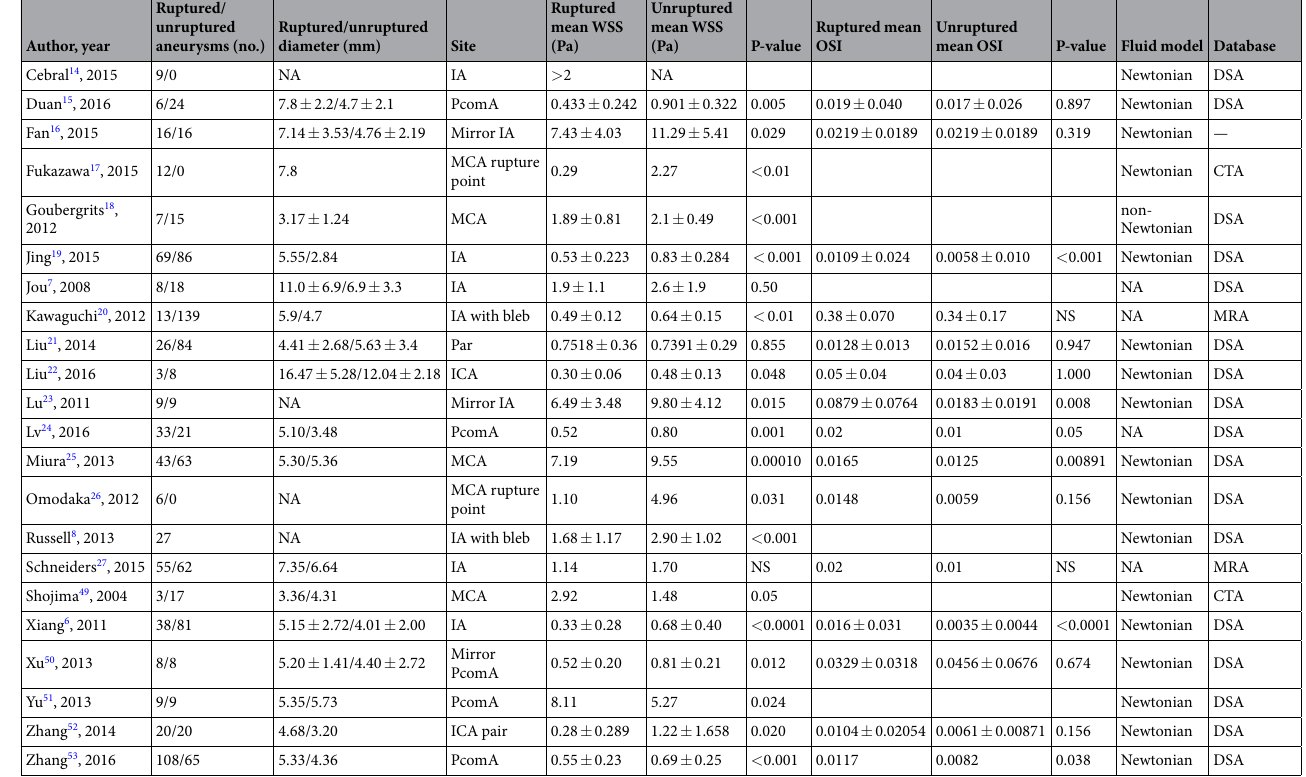
Table 1. Characteristics of studies included in the meta-analysis. Note: WSS, wall shear stress; OSI, oscillatory shear index; WSSG, WSS gradient; IA, intracranial aneurysm; ICA, internal carotid artery; Par, paraclinoid; PComA, posterior communicating artery; MCA, middle cerebral artery; NA, not available; DSA, digital subtraction angiography; CTA, computed tomographic angiography; MRA, magnetic resonance angiography; NS, not